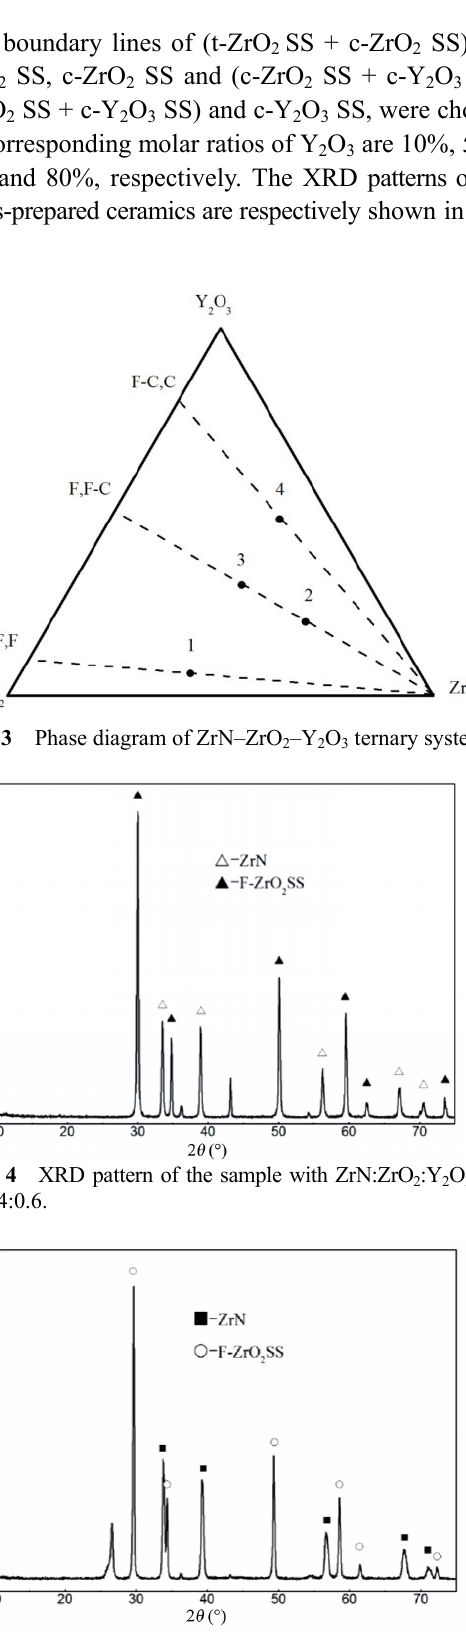
Fig. 5 XRD pattern of the sample with ZrN:ZrO 2 :Y 2 O 3 = 3:1:1.